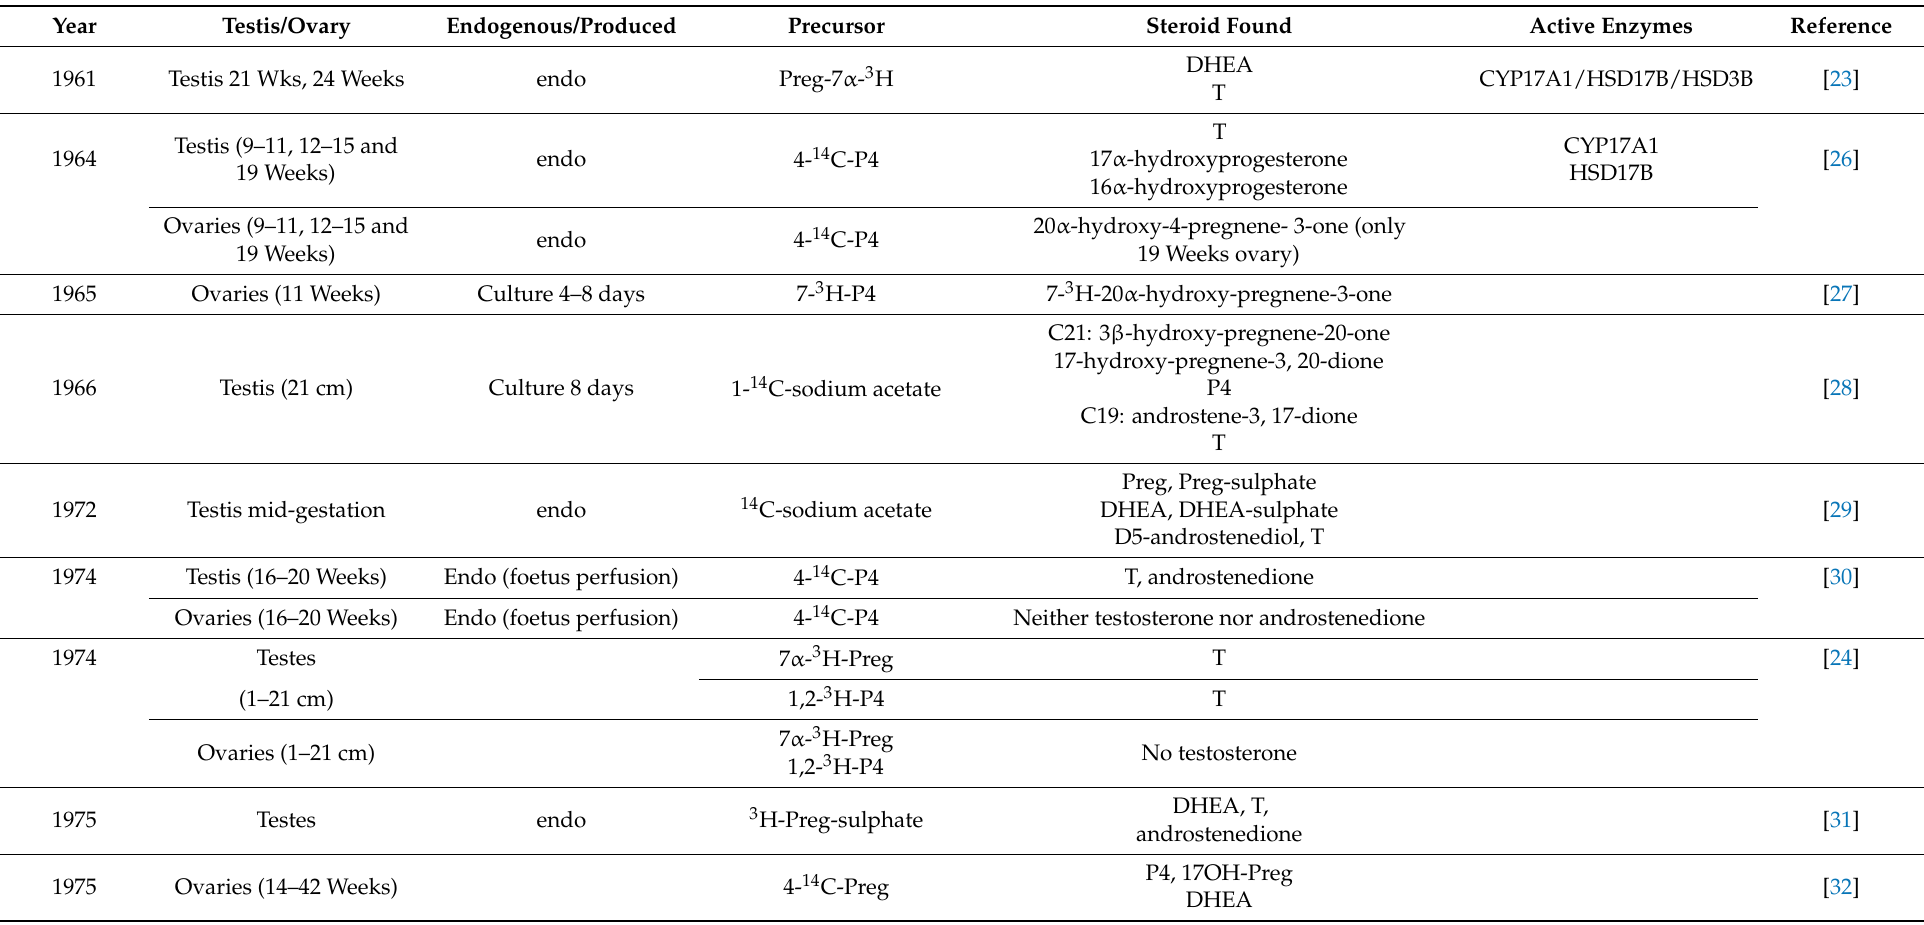
Table 1. Summary of steroid conversion experiments. Pregnenolone (Preg); 17-hydroxy-pregnenolone (17OH-Preg); Progesterone (P4); 17-hydroxy-progesterone (17OH-P4); dehy- droepiandrosterone (DHEA); androstenedione; testosterone (T); 5 α -dihydrotestosterone (DHT); and estrone